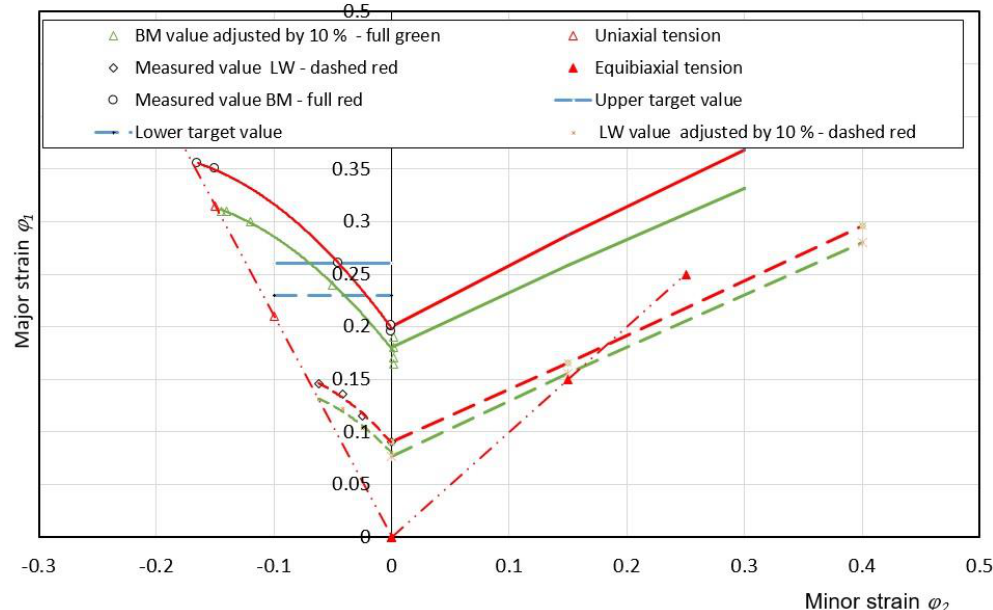
Figure 16. Forming limit diagram of the AISI 340 and AISI 340 LW materials.